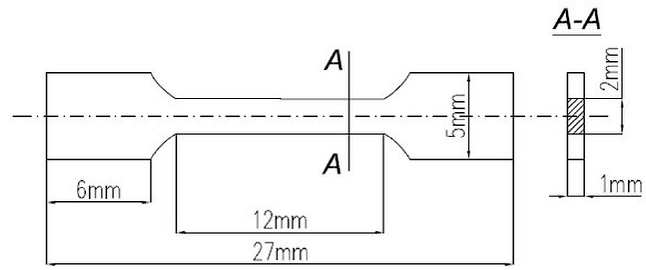
Figure 1. The tensile test specimen.